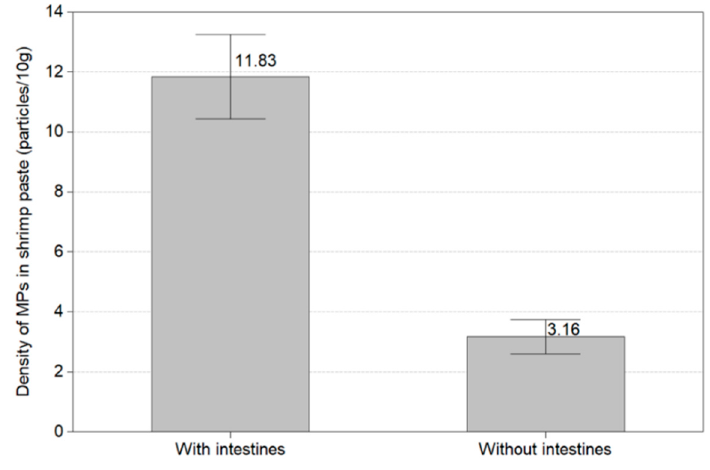
Figure 10. Amount of microplastics with and without the intestines and the head of shrimp. Figure 11 shows the size of microplastics with and without the intestines and heads of shrimps. The ratio of the number of microplastics in shrimps with the intestines and head resulted to be ≤ 50 µ m 25%, <50 to ≤ 100 µ m 20%, <100 µ m to ≤ 150 µ m 24%, <150 µ m to ≤ 200 µ m 20%, and >200 µ m 11%. The microplastic size ratio of shrimp without intestines and heads was ≤ 50 µ m 37%, <50 to ≤ 100 µ m 40%, and <100 µ m to ≤ 150 µ m 23%. The microplastic size of shrimp without the intestines and head was 150 µ m or less, whereas head. It was confirmed that microplastics with a size of 200 µ m or larger were included in the intestine and head of the shrimp.